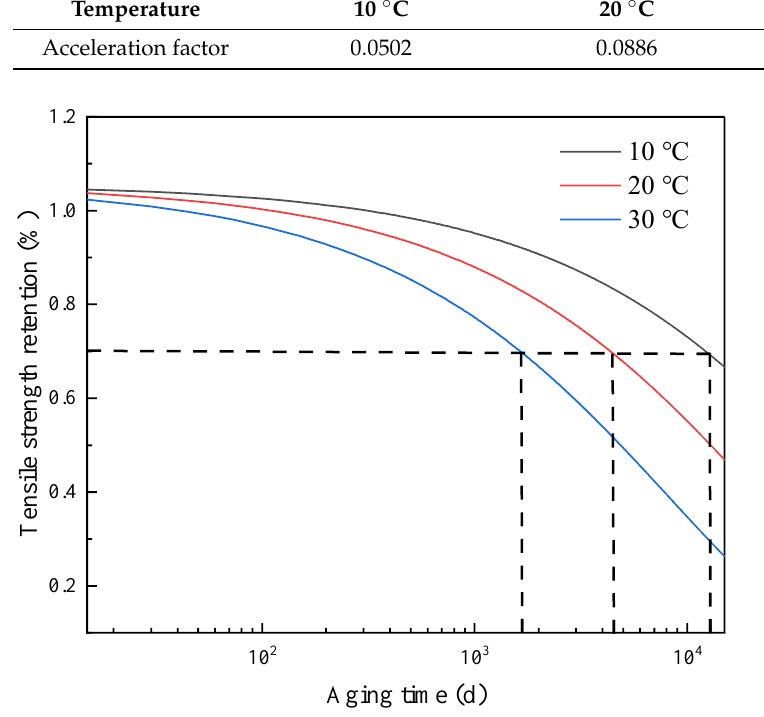
Figure 8. Performance degradation prediction curves at different temperatures. Table 3. Acceleration factor extrapolation results at low temperature.